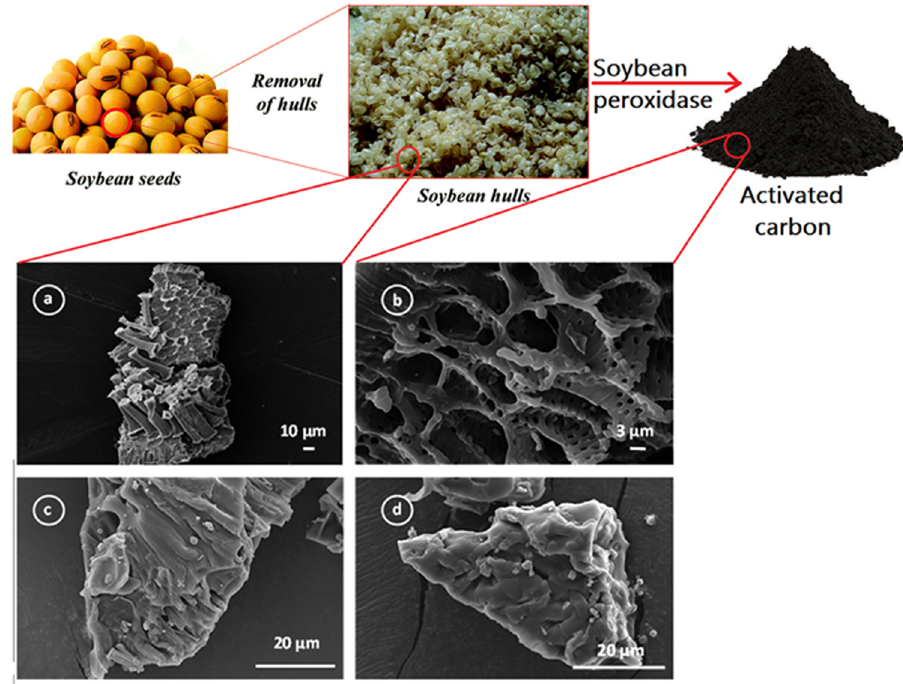
Figure 3: Removal of soybean hulls to produce AC and scanning electron microscopy ( SEM ) images of precursor ( soybean hulls ) for AC ( a ) after activation with ZnCl 2 and ( b ) after immobilization at di ff erent magni fi cations ( c ) and ( d ) . Copyright © 2017, Royal Society Publishing Group [ 345 ] .